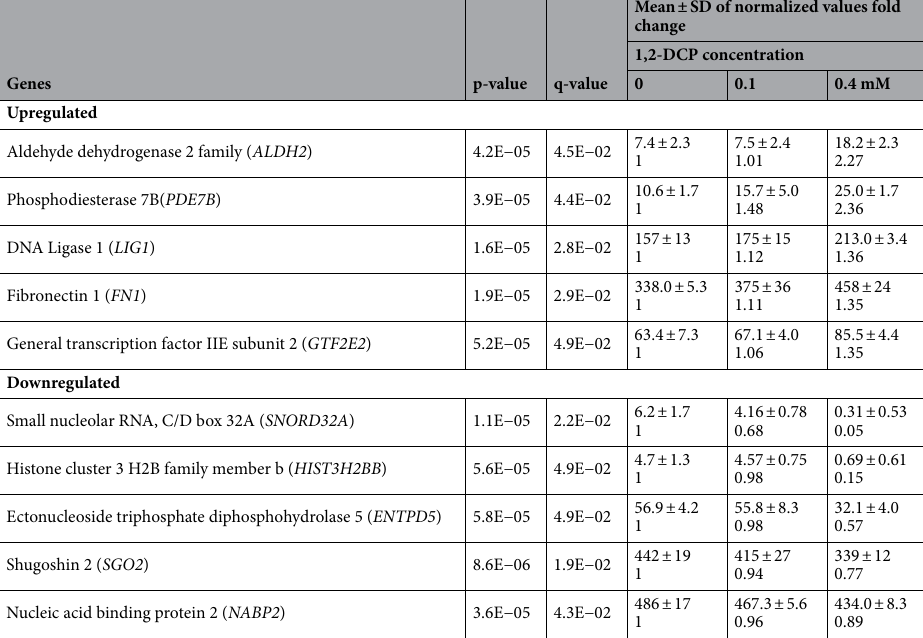
Table 4. Genes whose expression changed dose-dependently following exposure to 1,2-DCP in MMNK-1 cholangiocytes co-cultured with THP-1 macrophages. We tested the significance of Pearson correlation coefficient between the expression of each gene and 1,2-DCP level. The table lists the top or bottom five genes with the largest fold change at 0.4 mM in MMNK-1 cholangiocytes co-cultured with THP-1 macrophages when exposed to 1,2-DCP at 0, 0.1 or 0.4 mM for 24 h. Data of normalized values for gene expression are mean ± SD, n = 3. All p-values for gene expression were adjusted using Benjamini–Hochberg method and expressed as q-values. Fold change represents the value relative to the average of the control group (0